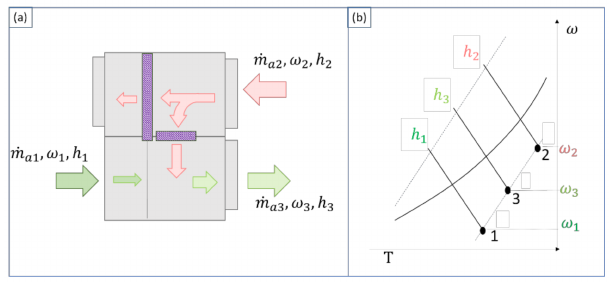
Figure 6. ( a ) Adiabatic mixture and ( b ) psychometric diagram of the